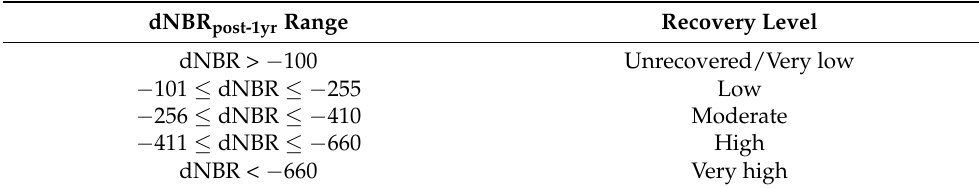
Table 2. Classification of dNBR post-1yr ranges as recovery